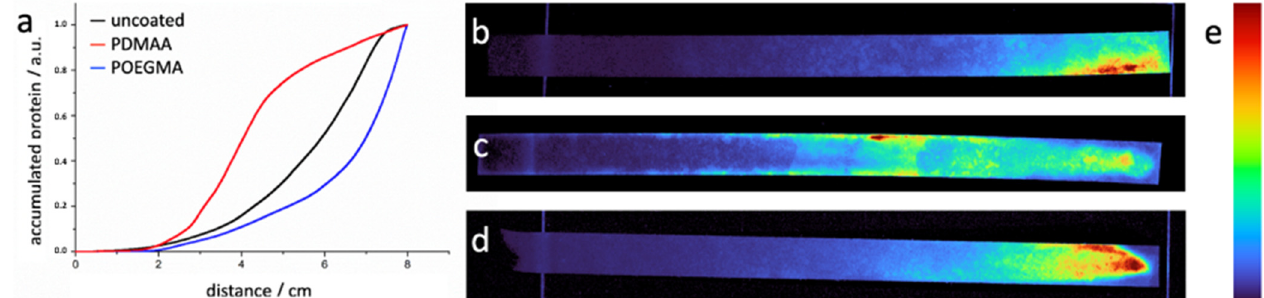
Figure 9. ( a ) A comparison of three experiments with the same conditions, but differently coated paper. The protein GFP was applied “with the flow” after 1 cm on the paper strip. The fluid used is PBS and the experiment is stopped once the entire paper is wetted. ( b ) The POEGMA coating allows the protein to reach the end of the strip and little protein is visible at the beginning and center of the strip. ( c ) The PDMAA-coated paper shows high retention of proteins. ( d ) The uncoated paper shows that the protein does not reach the end of the paper strip and has a lot of residue across the strip. ( e ) The look-up table stretches from violet (low signal intensity) to red (high signal intensity).